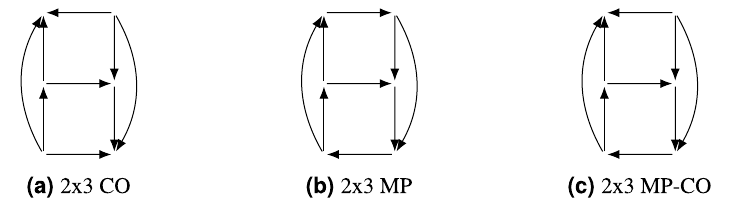
Figure 8. The three response graphs of generic non-dominated 2 × 3 games.